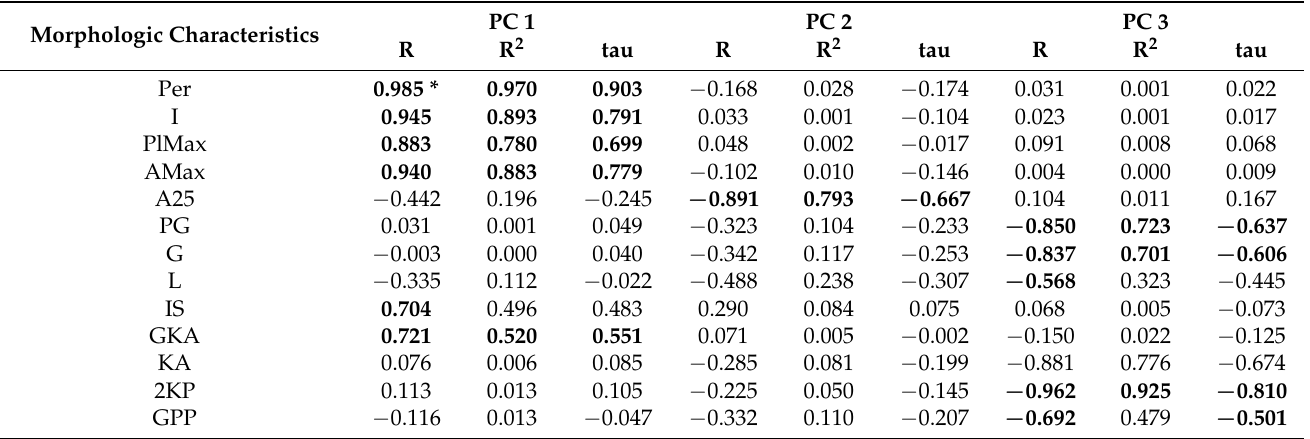
Table 3. Description of three main principal components (PCs) from the PCA on leaf traits with the highest R 2 from the ANOVA. Pearson’s (R) and Kendall’s correlations (tau) with the PCA ordination axes; n = 189. Morphologic